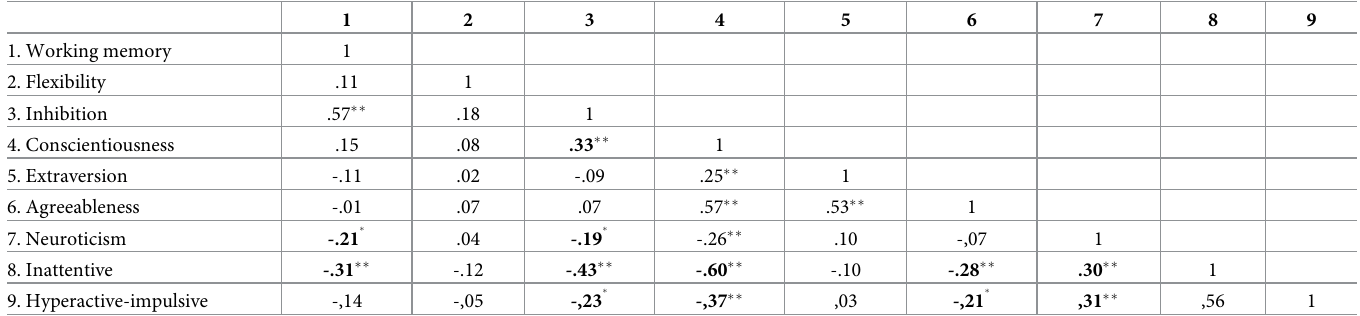
Table 3. Pearson correlations between cognitive EF factors, personality factors BFQ-C self-report and inattentive and hyperactive-impulsive symptoms of Con- ners-3 parent report (DSM subscales) for ADHD and control groups ( N = 118).